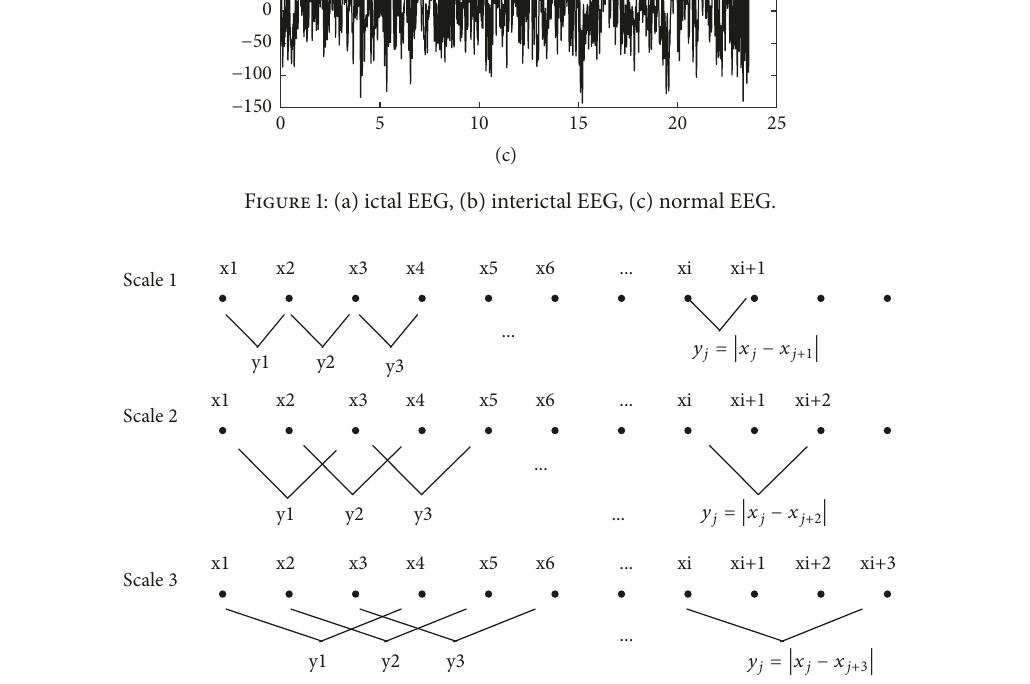
Figure 2: Illustration of MSLD [11].